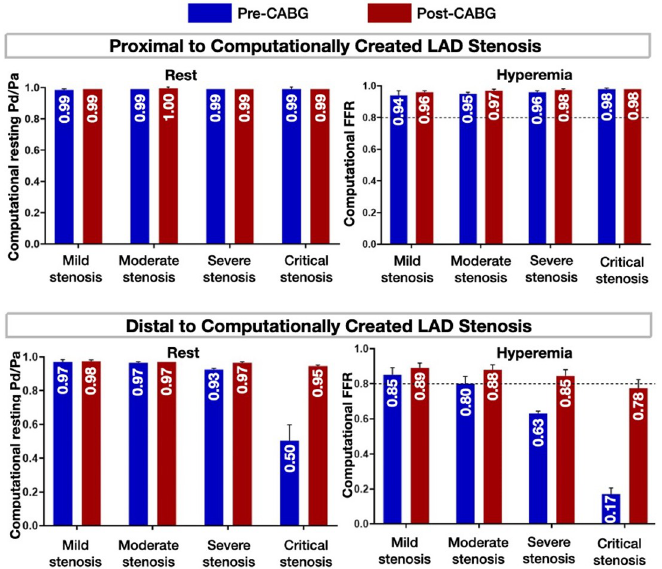
Fig 5. Effect of LIMA grafting on LAD hemodynamics. Computational calculation of the pre-and post-CABG resting Pd/Pa (resting conditions) and FFR (hyperemic conditions) proximal and distal to the computationally created stenosis. Values are expressed as mean ± SD. Note the normalization of FFR by grafting severe stenosis and near normalization of FFR by grafting critical stenoses (red bars; dashed lines represent the FFR ischemic cut-off of 0.80; Pd/Pa: distal pressure/aorta pressure, FFR: fractional flow reserve, CABG: coronary artery bypass grafting, LAD: left anterior descending artery, SD: standard deviation).